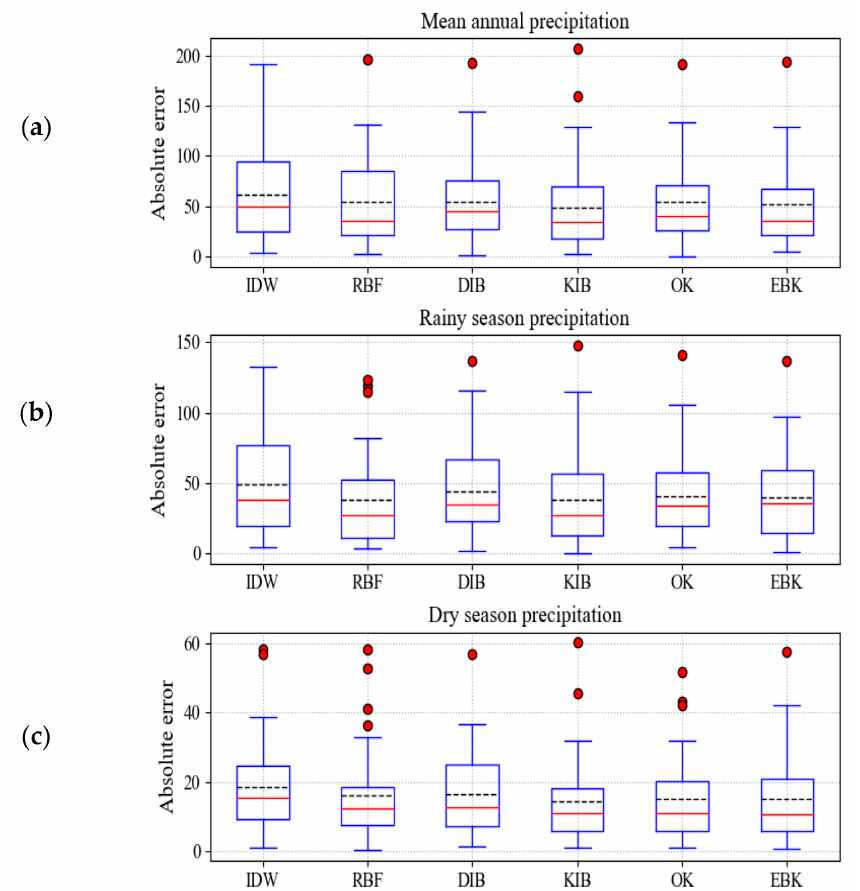
Figure 5. Boxplots of absolute errors in estimating precipitation by six interpolation methods under different climatic conditions: ( a ) mean annual; ( b ) rainy season; and ( c ) dry-season precipitation. Units are calculated in